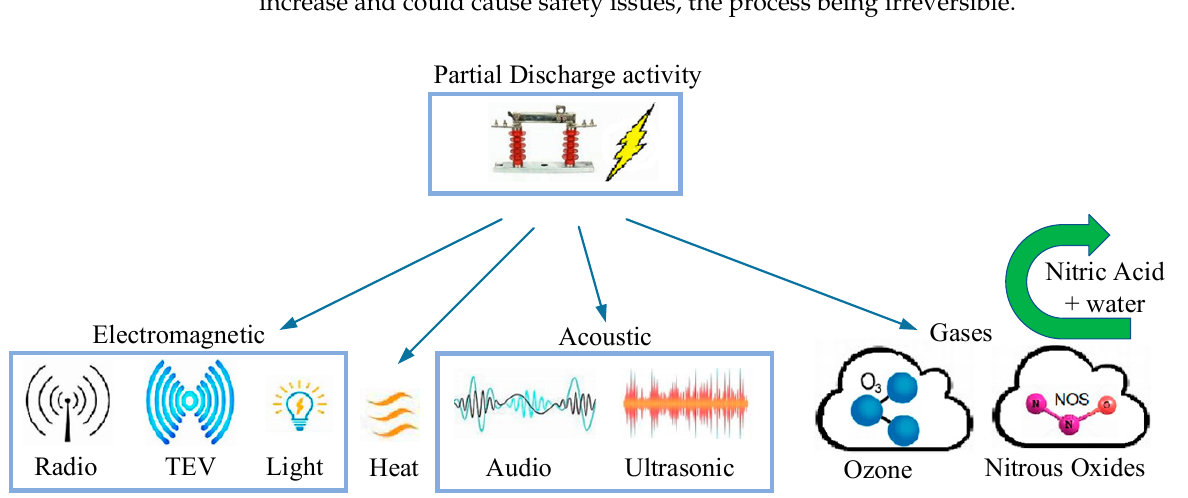
Figure 3 . Partial discharge energy emissions . Figure 3. Partial discharge energy